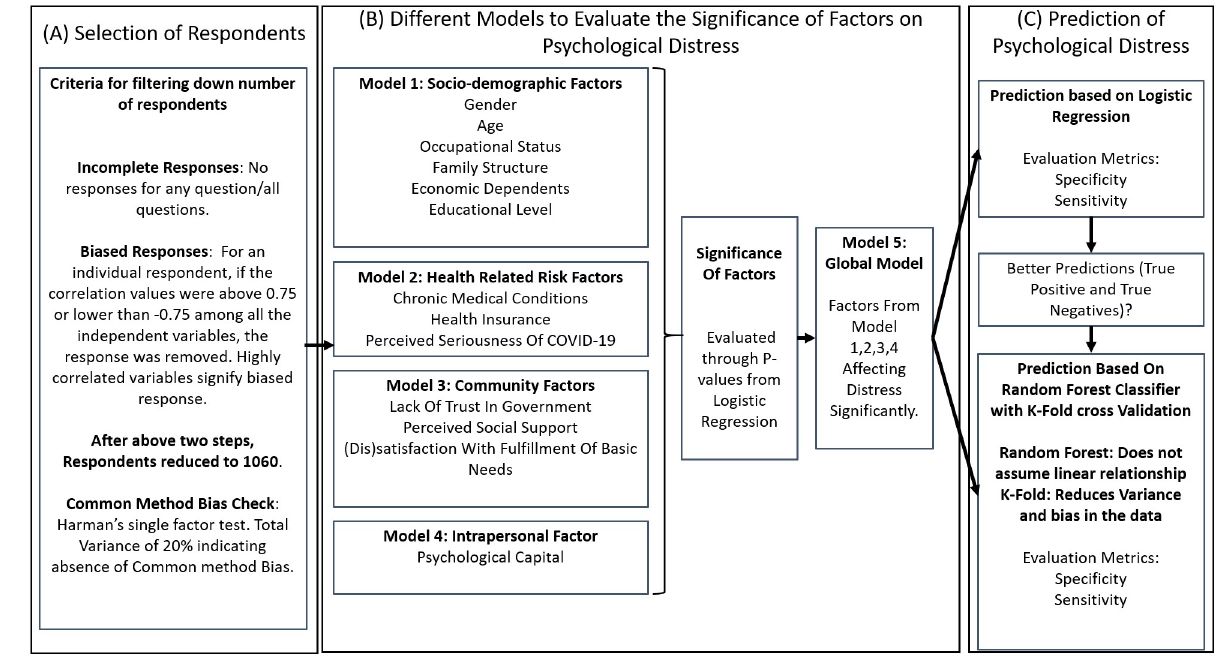
Fig 1. Conceptual framework for the